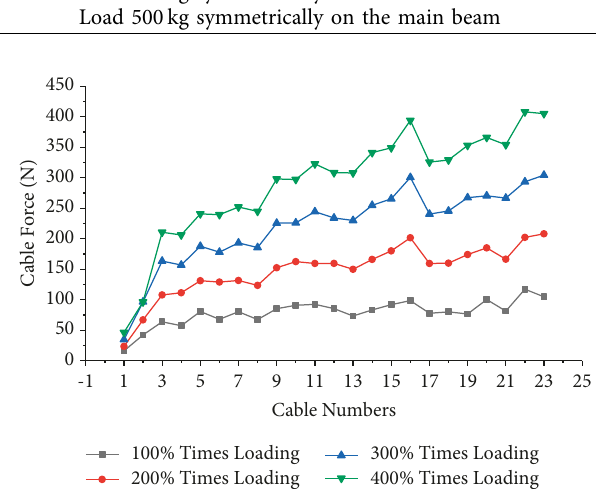
Figure 8: Comparisons of cable forces under 100% ∼ 400% times loading.